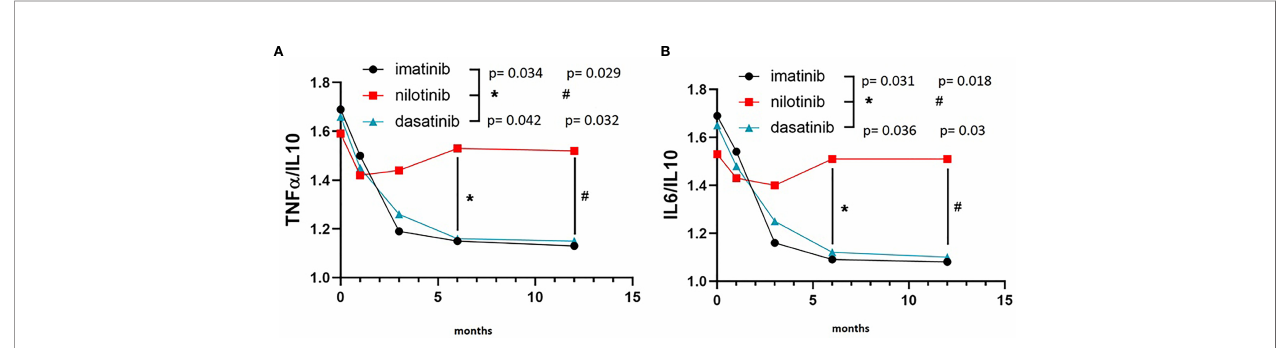
FIGURE 3 | TNF a /IL10 and IL6/IL10 ratios in the three cohorts. (A) Three-way ANOVA. TNF a /IL10 ratio was signi fi cantly higher in nilotinib cohort at 6 and 12 months compared with imatinib (F=3.870, p=0.034 at 6 months and F=4.010, p=0.029 at 12 months) and dasatinib (F=3.620, p=0.042 at 6 months and F=3.960, p=0.032 at 12 months). (B) Three-way ANOVA. IL6/IL10 ratio was signi fi cantly higher in nilotinib cohort compared with imatinib (F=3.990, p=0.031 at 6 months and F=4.210, p=0.018 at 12 months) and dasatinib (F=3.800, p=0.036 at 6 months and F=4.020, p=0.03 at 12 months). Symbols "*" and “ # ” are referring to statistical differences reported with p values of TNF a /IL10 ratio (A) at 6 (*) and 12 (#) months of treatment in nilotinib group compared to imatinib and dasatinib. In (B) symbols "*" and “ # ” are referring to statistical differences reported with p values of IL6/IL10 ratio at 6 (*) and 12 (#) months of treatment in nilotinib group compared to imatinib and